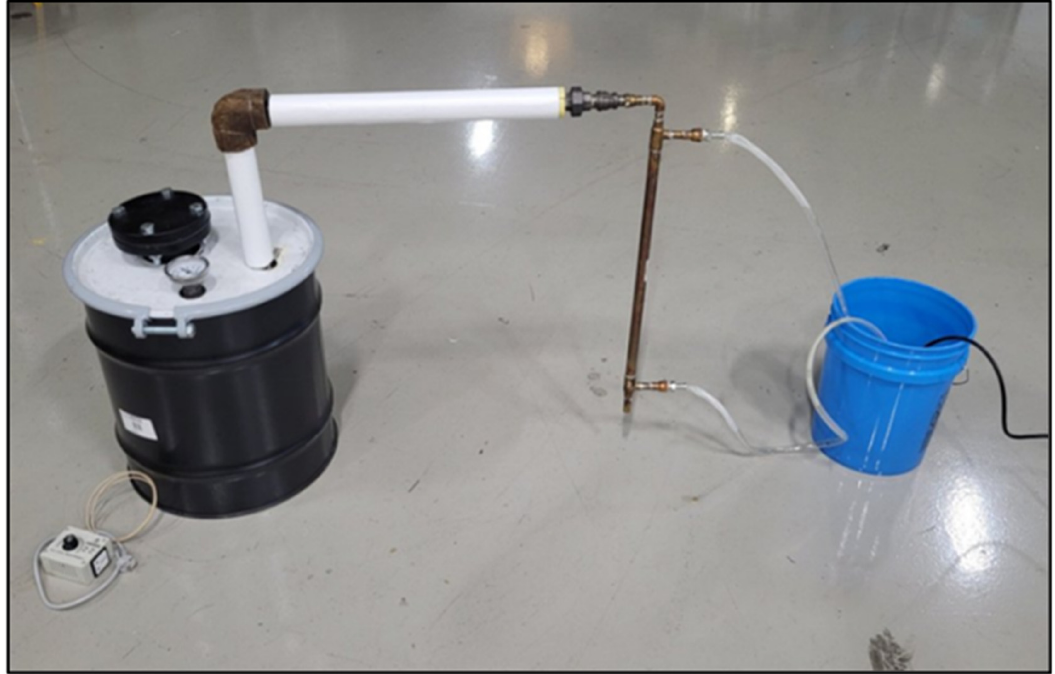
Figure 1. 3T processor designed using the principles of appropriate technology.